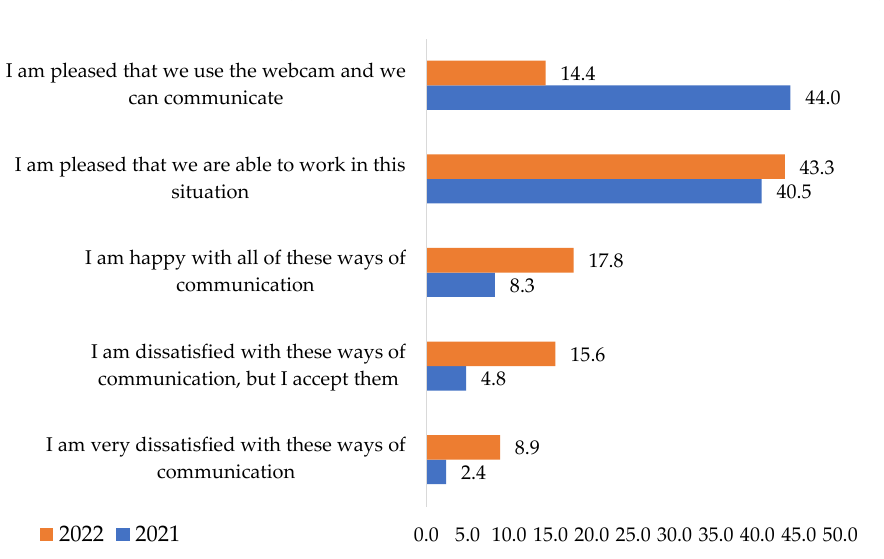
Figure 4. The satisfaction/dissatisfaction degree in the online communication with colleagues (e.g., Microsoft Teams, Skype, etc.). Source: Data from field quizzes, 2021, 2022.